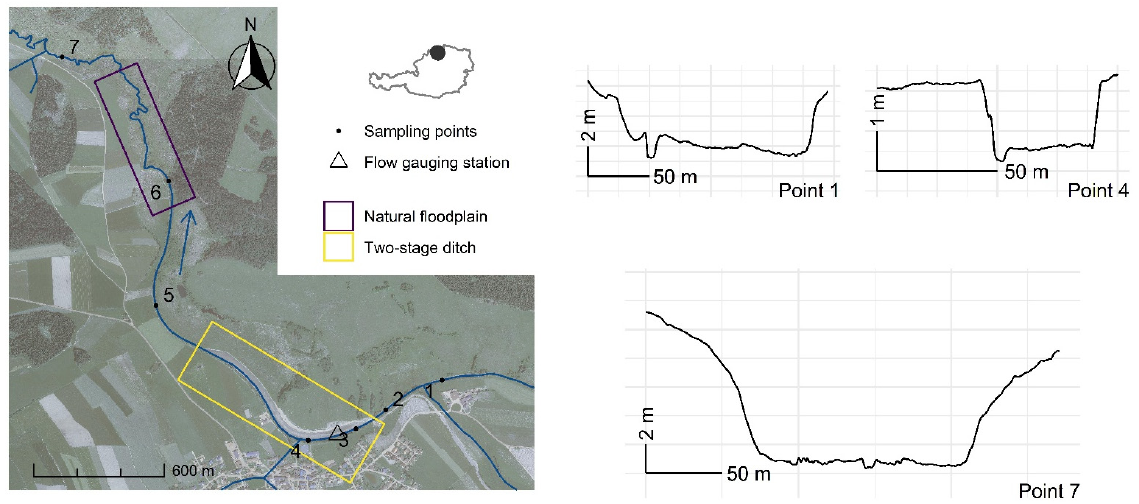
Figure 1. Study site overview ( left ), including the drawing of three representative cross sections ( right ). The blue arrow shows the direction of the flow; the numbers indicate the sampling sites. The channelized cross section is representative of the pre-restoration status.